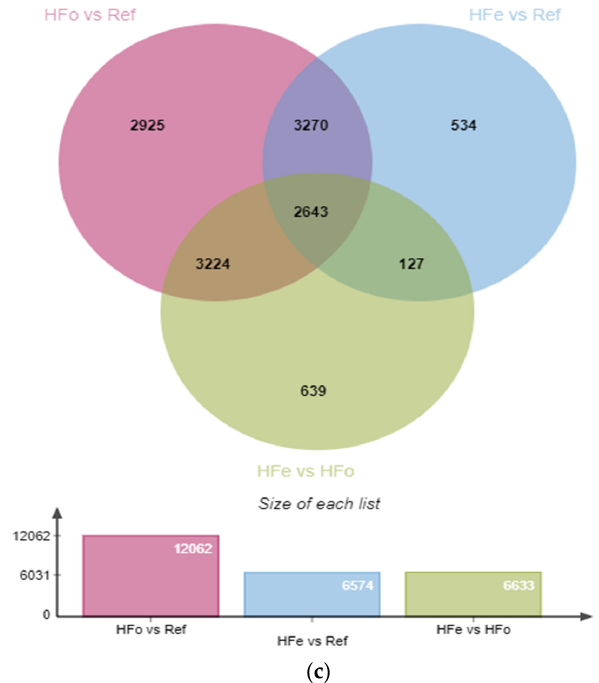
Figure 1. Modulation of gene expression adaptation during an obesogenic diet following transgenerational intake of EPA. ( a ) Venn diagram illustrating the genes differentially expressed in each comparison (significantly identified mRNA with p < 0.05 after FDR correction for multiple testing). ( b ) PLS-DA plot of mRNA expression levels of significantly regulated transcripts ( p < 0.05 after correction for multiple testing). ( c ) Venn diagram illustrating the genes differentially expressed in each comparison (significantly identified mRNA with p < 0.05 before FDR correction for multiple testing). HFoleic (or HFo), mice from oleic/control lineage fed with the obesogenic diet; HFepa (or HFe), mice from EPA/omega 3 lineage fed with the obesogenic diet; Reference (or ref), mice from oleic/control lineage fed with the normocaloric diet. Table 1. Comparison of VAT’s gene expression data in microarray and RT-qPCR measurements. Values are mRNA level ratio between the different groups ( n = 6/8 per group). Microarray experi-